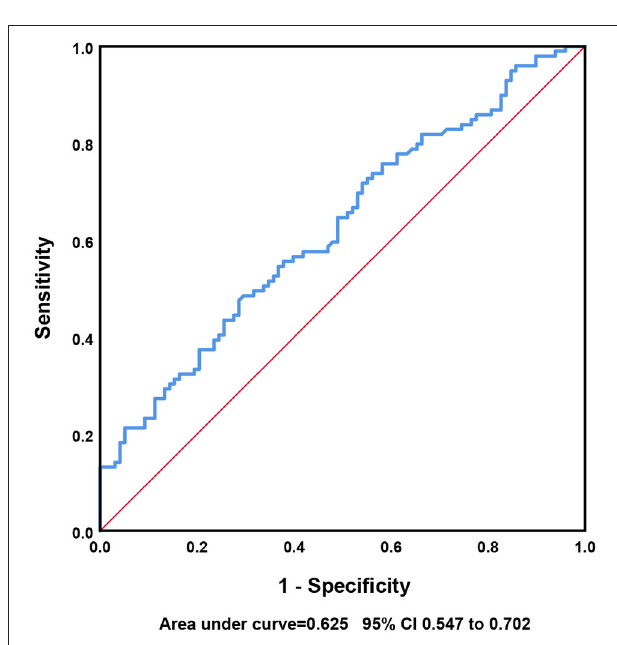
FIGURE 3 | ROC analysis diagram.